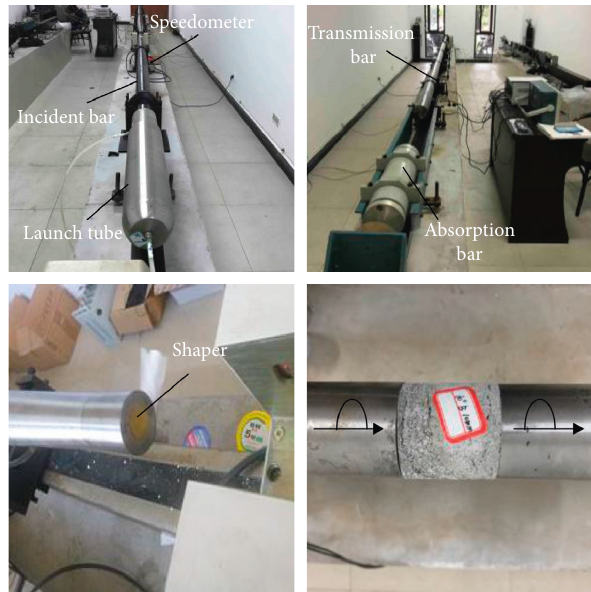
Figure 3: Test device of